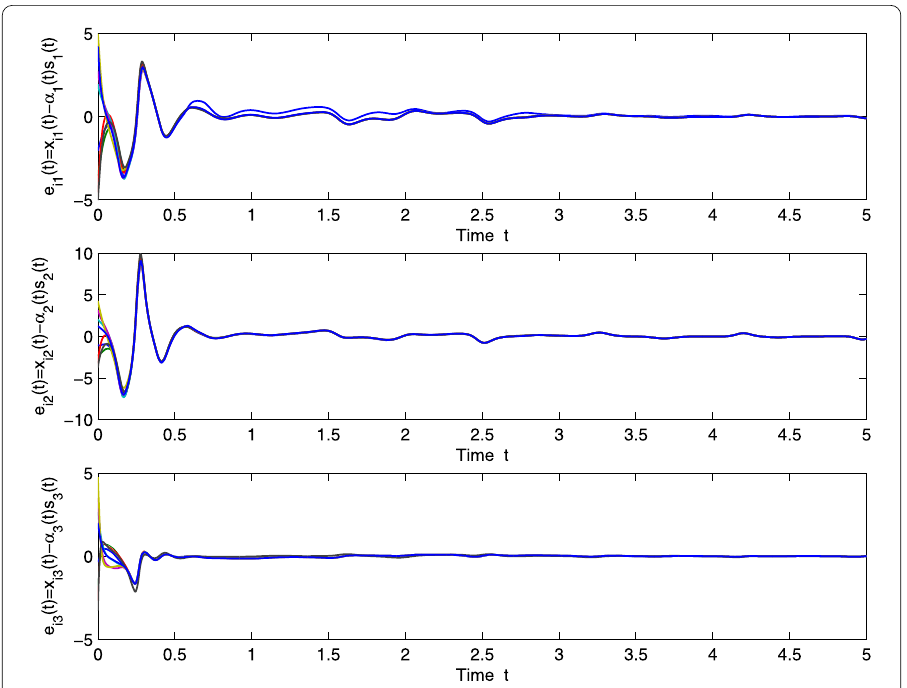
Figure 11 The modified function projective synchronization errors between the states of isolate node α ( t ) s ( t ) (40) and node x i ( t ) (41), i = 1,...,8, with hybrid adaptive control (5).